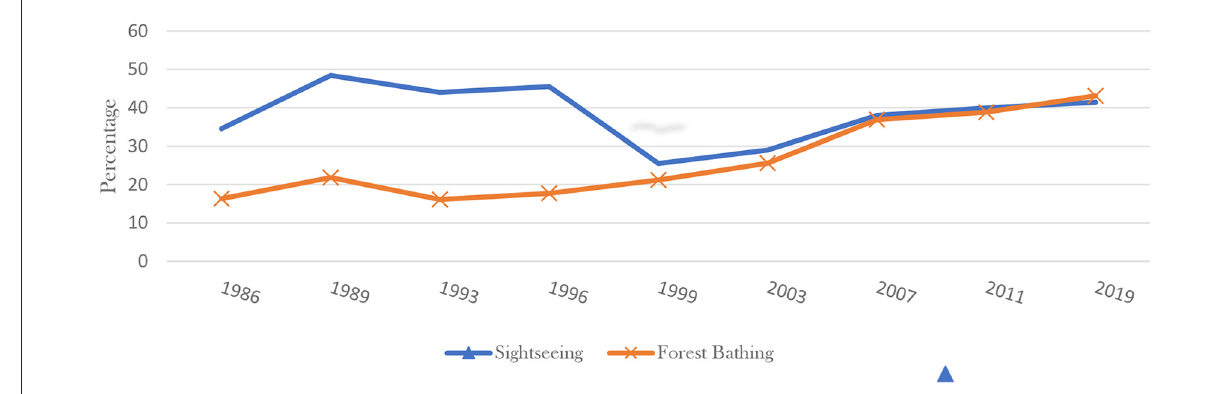
FIGURE1 Forest bathing accounts for the percentage of people who go to the